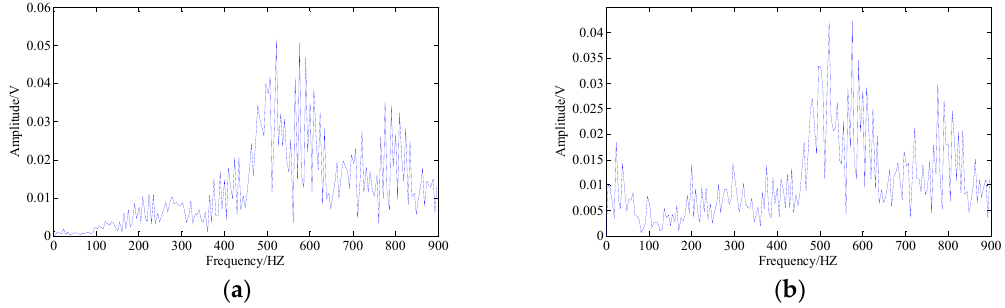
Figure 15. The result provided by canonical decomposition and parallel factors by alternating least squares method (CP-ALS): ( a ) recovered No. 1 fault signal; and ( b ) recovered No. 2 fault signal.